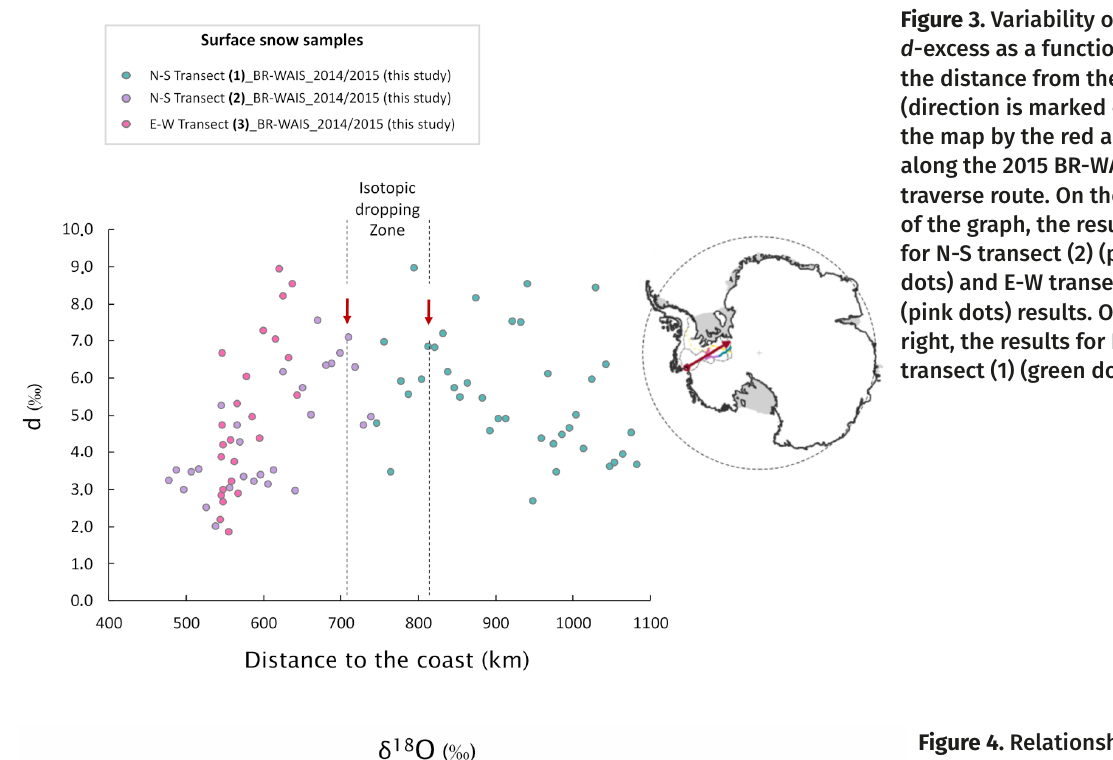
Figure 4. Relationship between δ 18 O and δD along the 2015 Brazilian traverse route. Gray dots are data from the surface snow